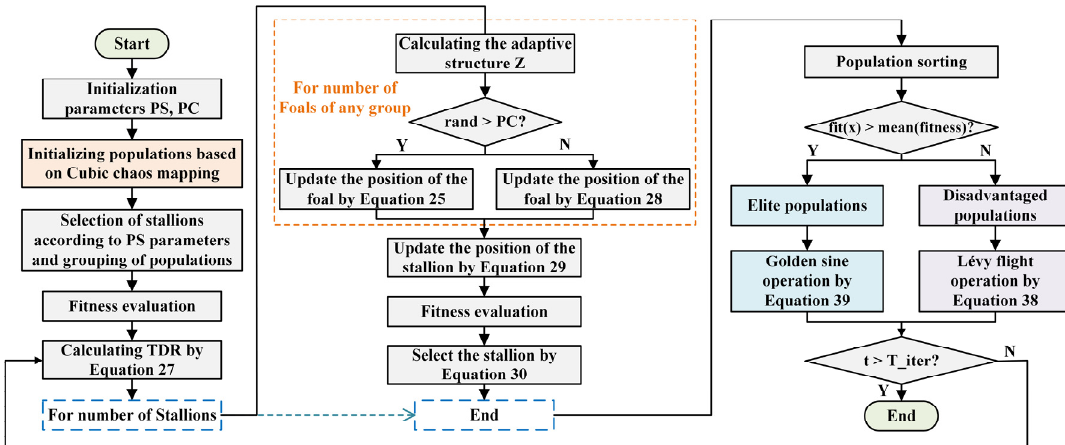
Figure 1. Flowchart of the improved wild horse optimizer.